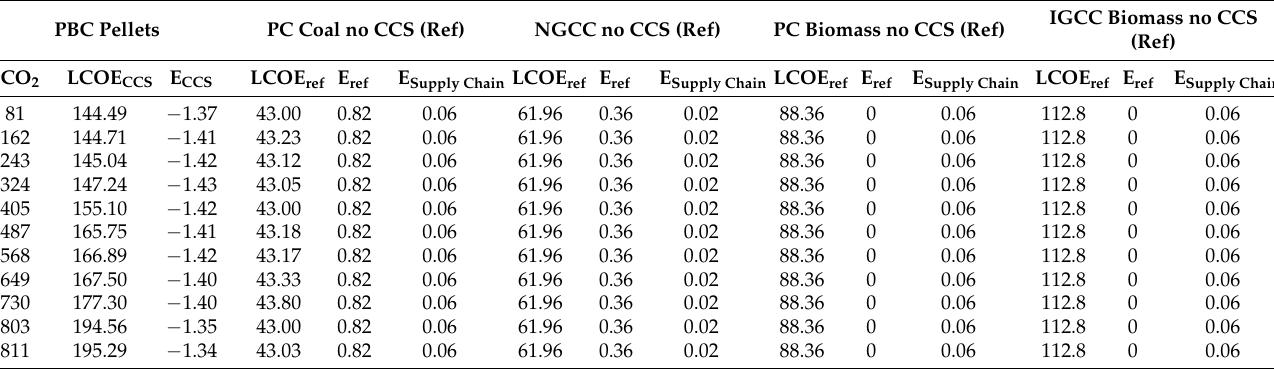
Table A4. Levelized Cost of Electricity (LCOE, in $/MWh) and Emissions Intensity (E, in tCO 2 /MWh) for the four CAC reference cases and PBC powerplants.